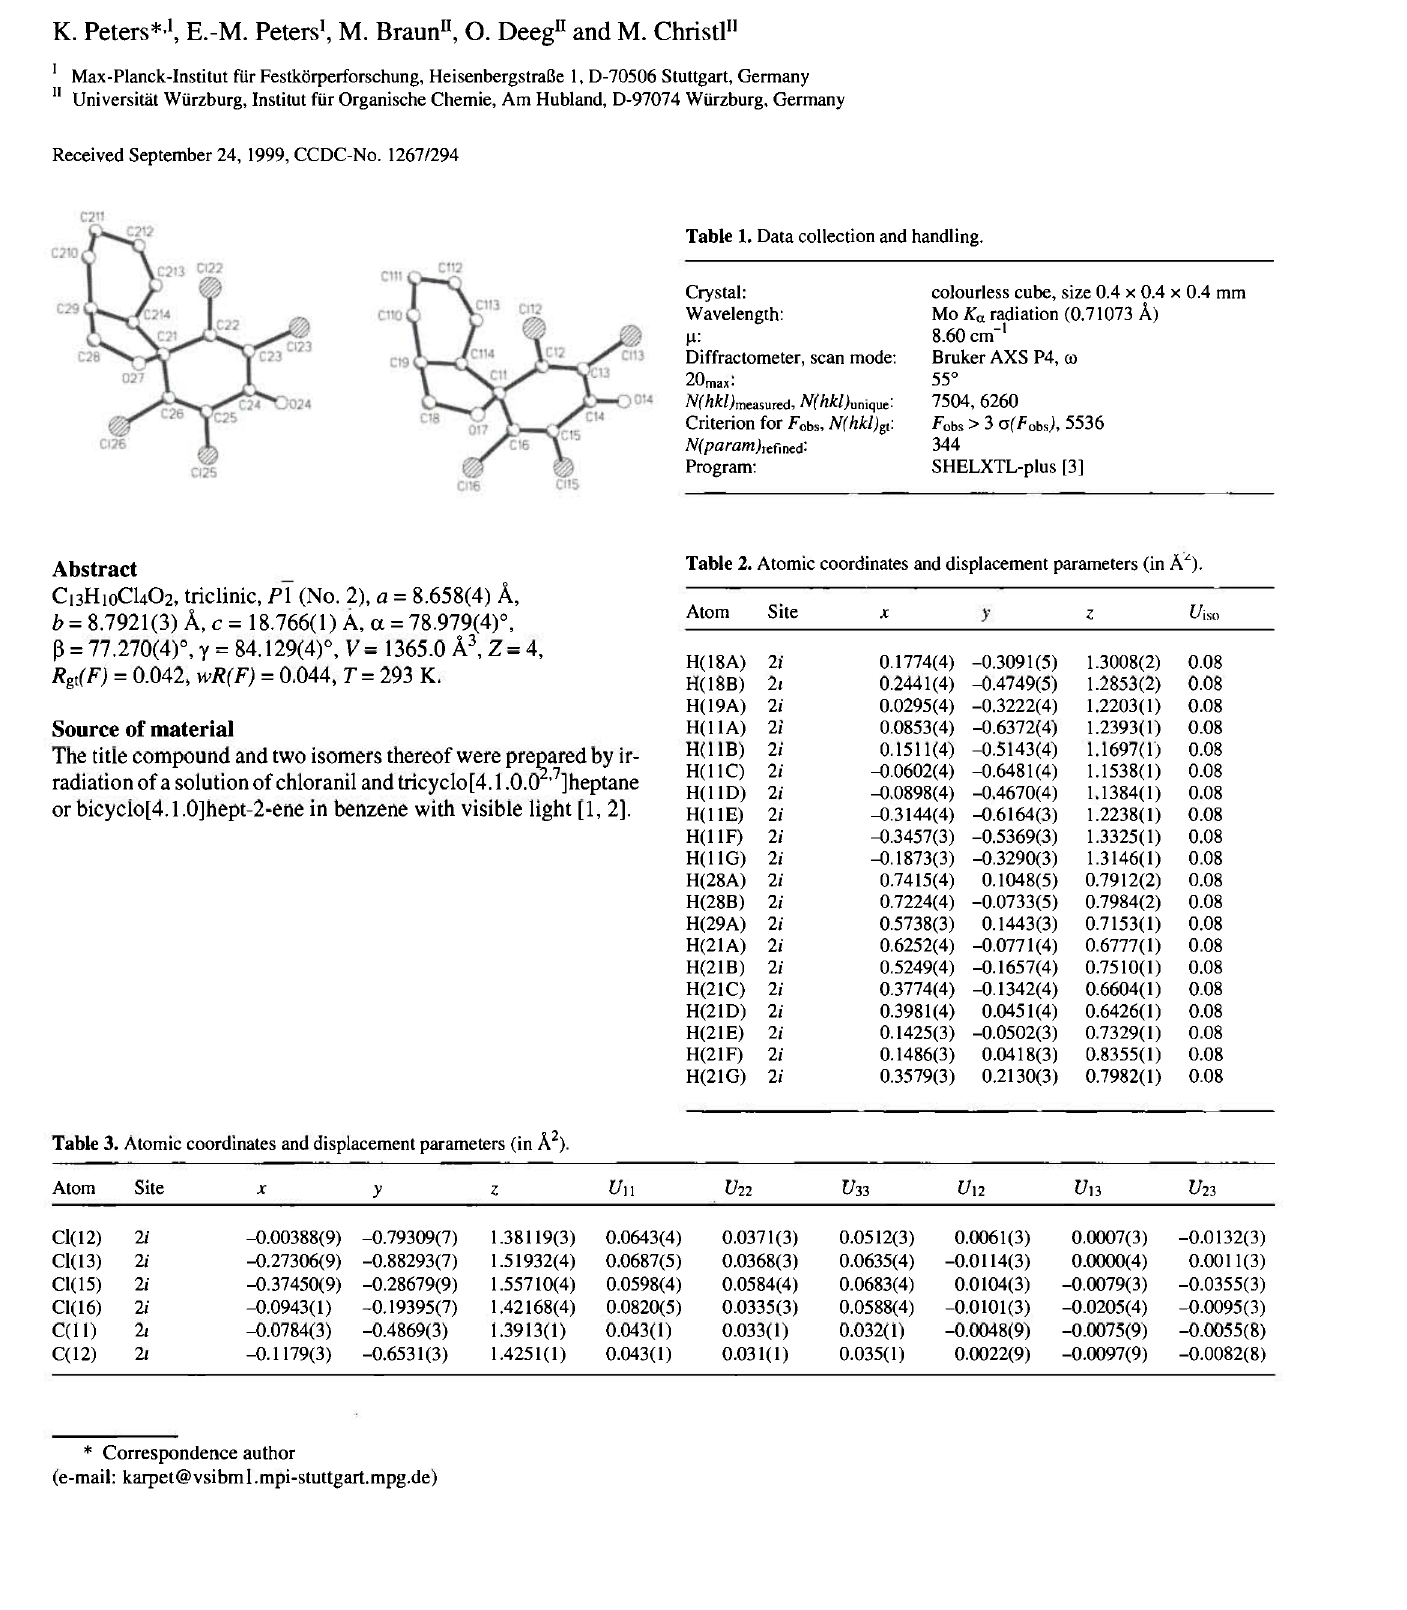
Table 1. Data collection and handling.